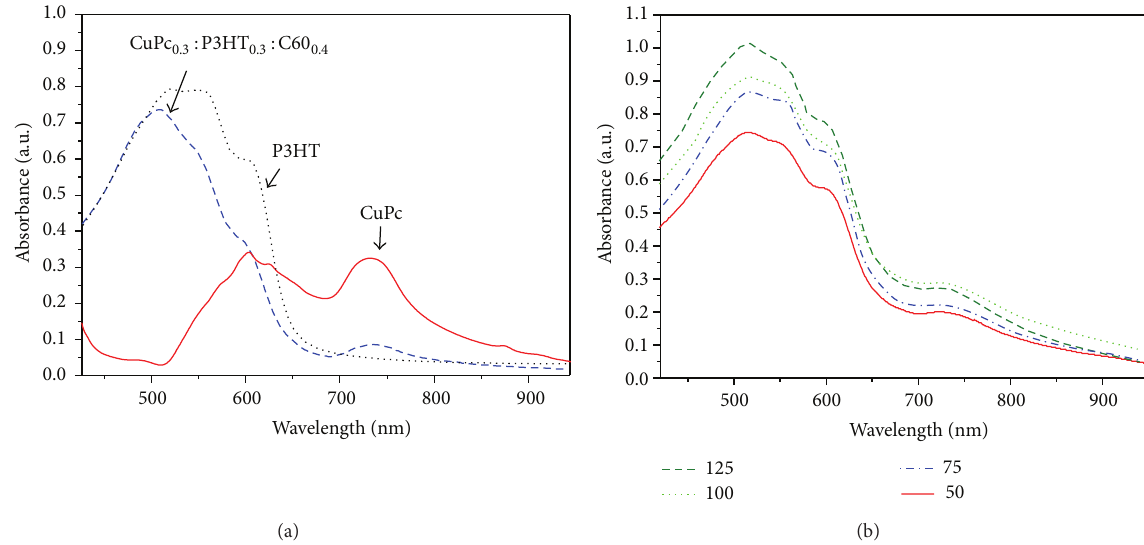
Figure 2: The absorbance spectra of (a) CuPc (solid line), P3HT (dotted line), and P3HT 0.3 :CuPc 0.3 :C60 0.4 before annealing (dashed line) and (b) P3HT 0.3 :CuPc 0.3 :C60 0.4 after annealing at different temperatures.